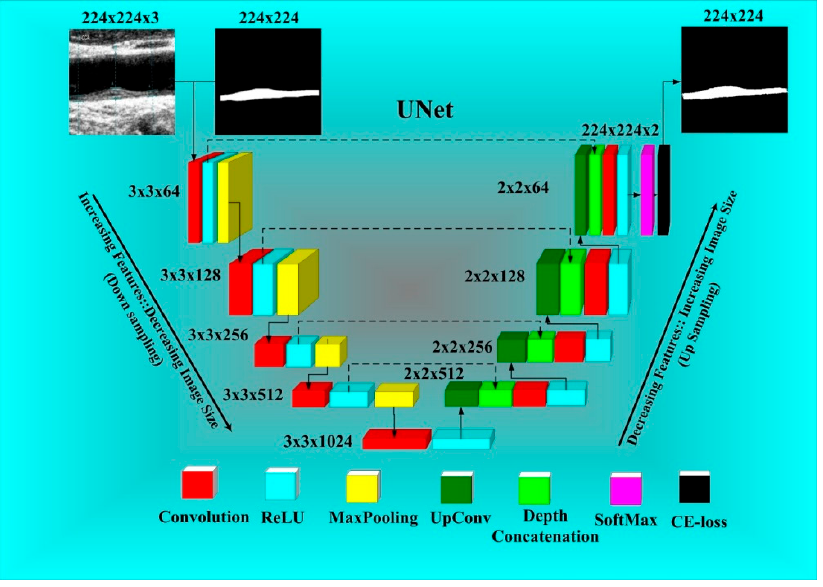
Figure 2. UNet: Four-layer DL architecture for atherosclerotic plaque wall